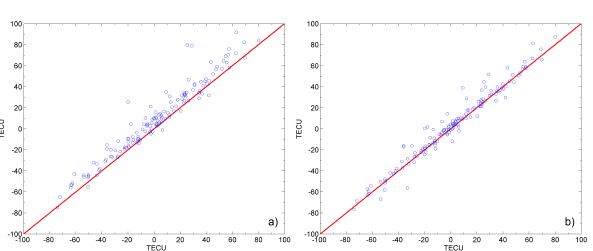
Figure 8 aims to explain multi-resolution with DM